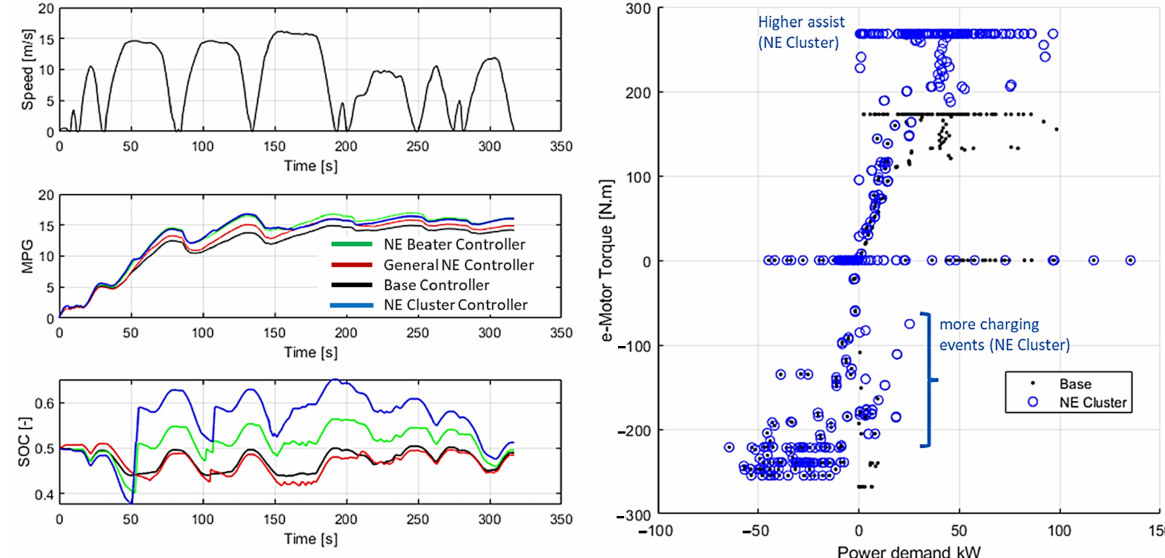
Figure 13. HEV operation comparison between the four hybrid controllers. The charging and assist strategy is highlighted for the base and NE Cluster controllers on the right.